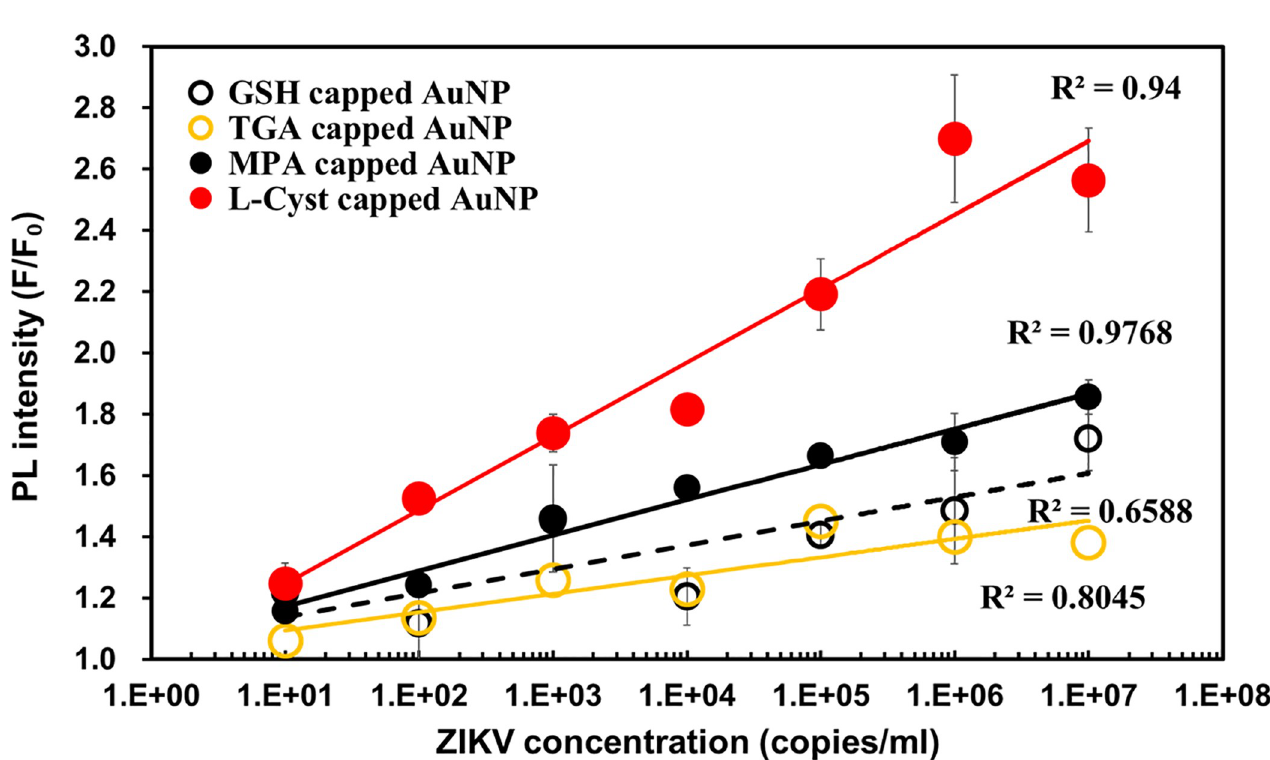
Fig 5. Calibration curves of ZIKV detection using 4 kinds of thiol-functionalized AuNPs. The LSPR signal amplifiers of L -cyst-AuNPs (red closed circles) and Ab-MPA-AuNPs (black closed circles) showed higher correlation coefficients than those of Ab-GSH-AuNPs (black open circles) and Ab-TGA-AuNPs (yellow open circles).